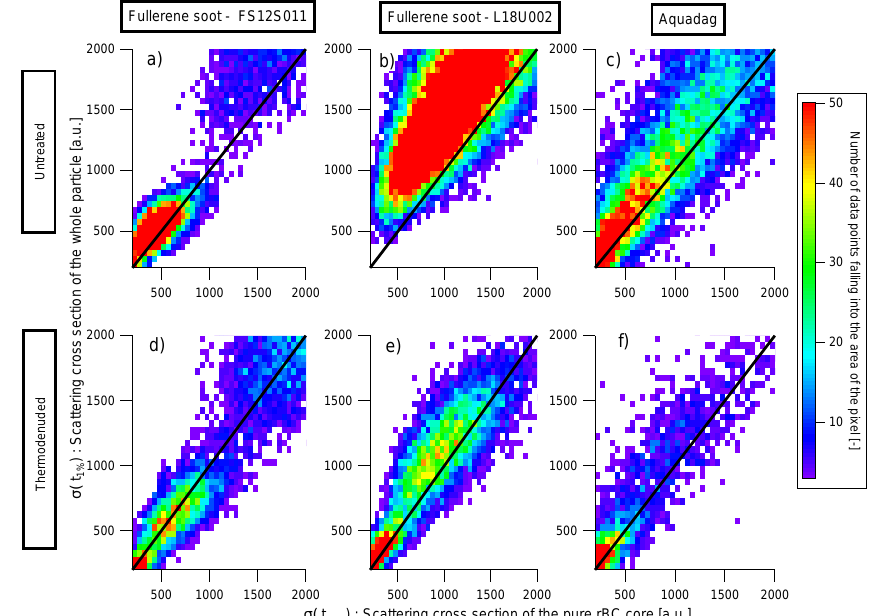
Fig. 7. Estimate of the coating on untreated (top panels) and thermodenuded (bottom panels) samples: fullerene soot batch FS12S011 (a, d) , fullerene soot batch L18U002 (b, e) , Aquadag® (c, f) . The data points corresponding to uncoated particles will lie around the one-to-one line while coated particle data points will be shifted above